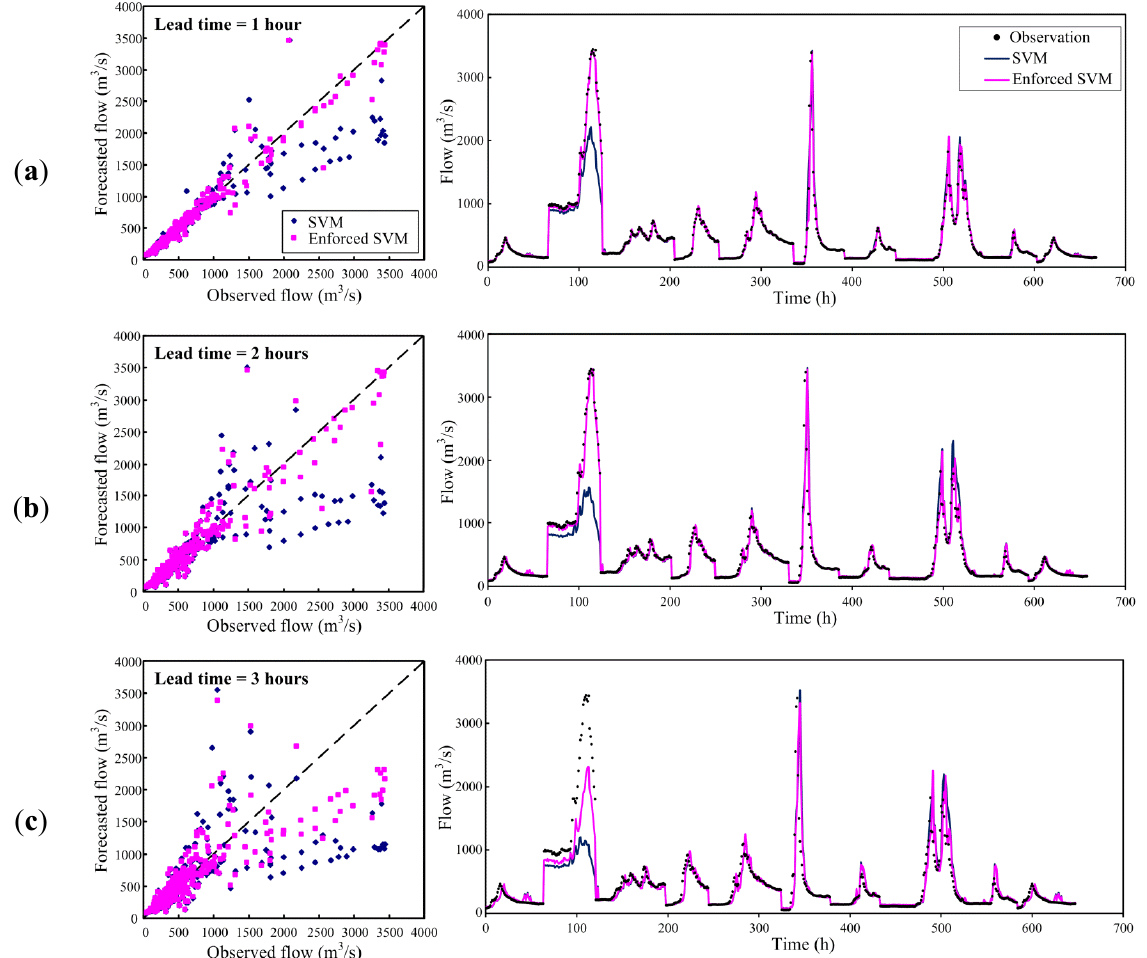
Figure 8. Observed flows versus corresponding forecasts resulting from the SVM and the enforced SVM models: ( a ) 1-h ahead; ( b ) 2-h ahead and ( c ) 3-h